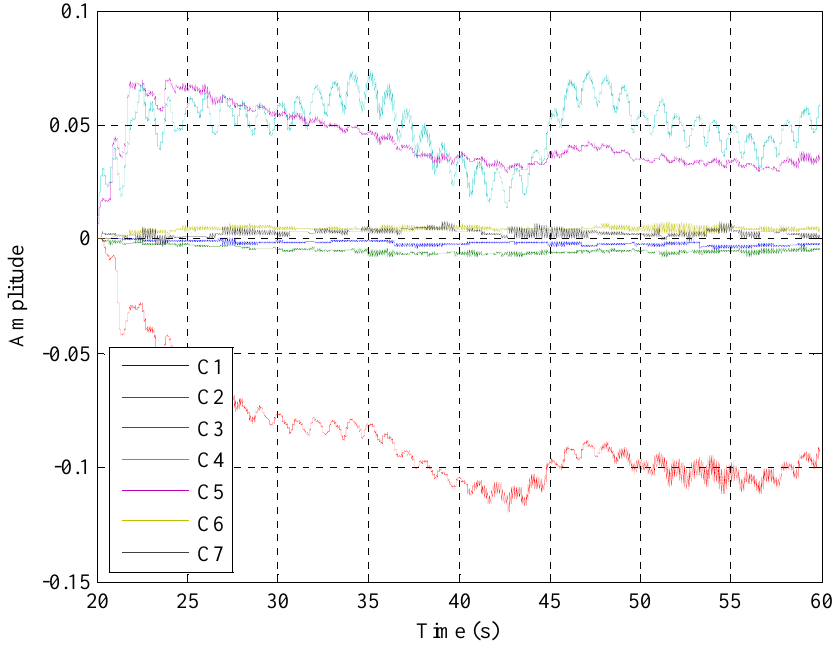
Figure 15. Fuzzy rule bank used in AFMSC vibration control system.